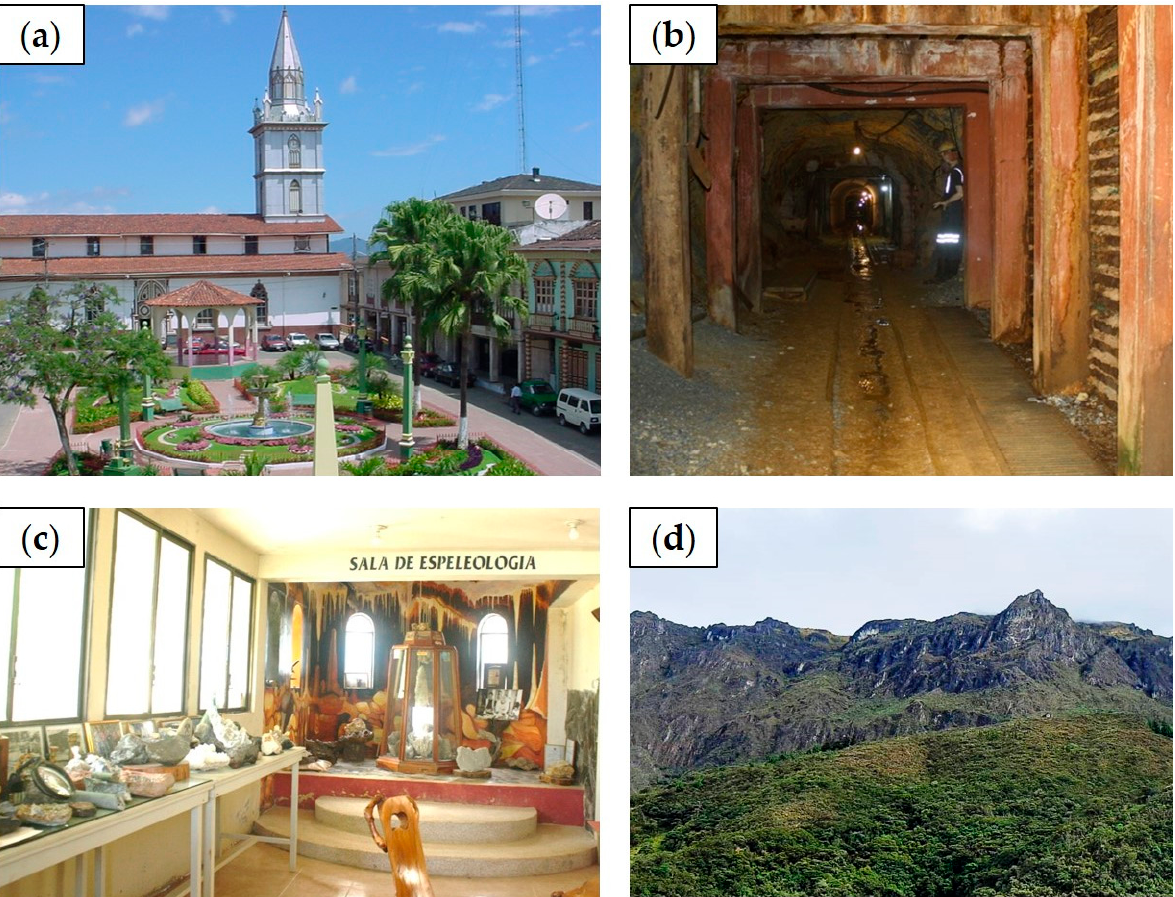
Figure 4. Primary sites of tourist interest in the study area. ( a ) Historic downtown of Zaruma; ( b ) El Sexmo mine; ( c ) Magner Turner mineralogical museum and ( d ) Los Arcos hill.